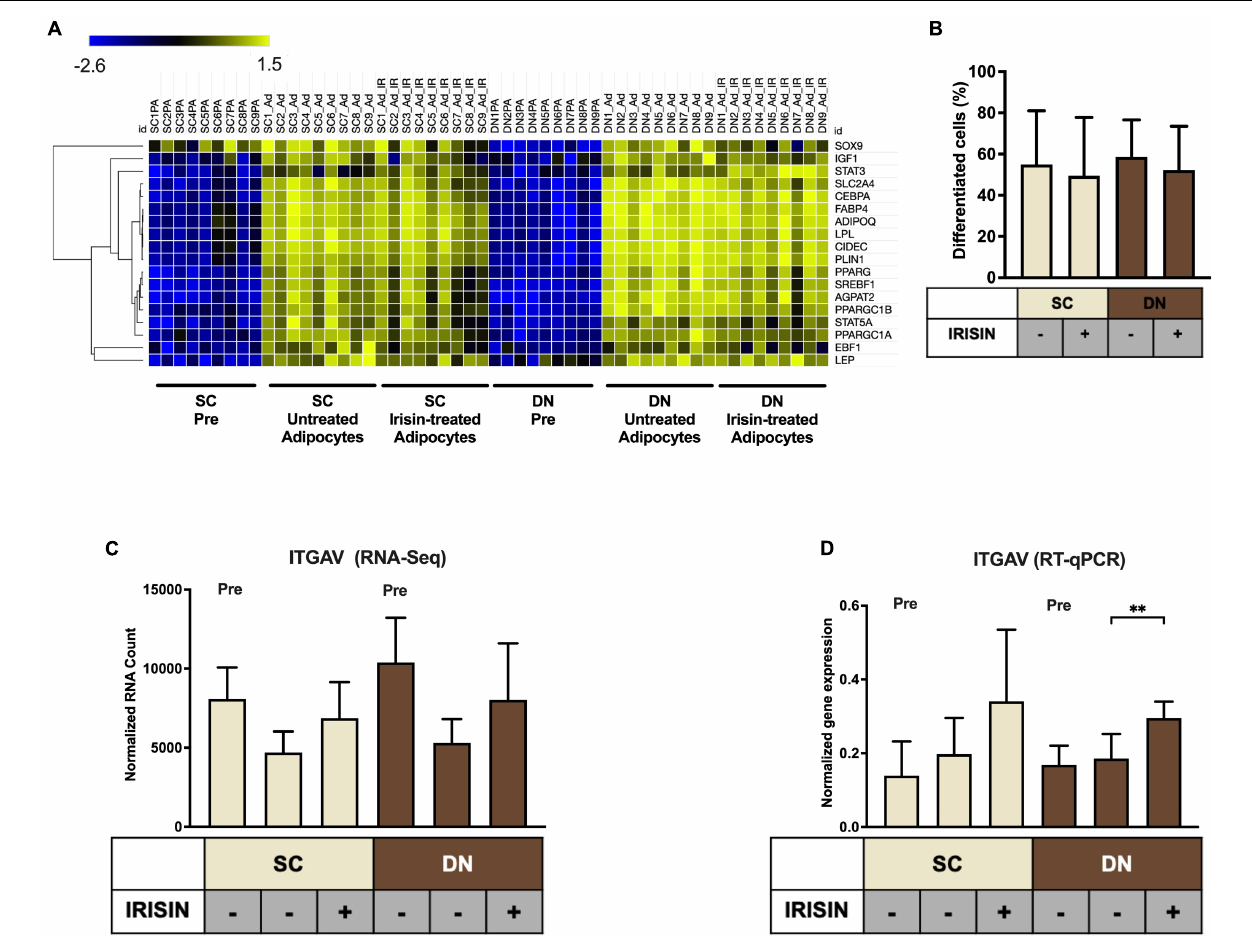
FIGURE 1 | Preadipocytes from subcutaneous (SC) and deep-neck (DN) depots of human neck differentiated at a similar extent irrespective of the presence of irisin. SC and DN preadipocytes (Pre) were differentiated for 2 weeks to white adipocytes. Where indicated, 250 ng/ml irisin was administered during the whole differentiation process. (A) Heatmap illustrating the expression of general adipogenic differentiation markers in samples used for Global RNA Sequencing ( n = 9), (B) Quantification of differentiation rate by laser-scanning cytometry ( n = 9), (C) Quantification of ITGAV gene expression determined by RNA Sequencing ( n = 9), and (D) RT-qPCR, normalized to GAPDH ( n = 5). Data presented as Mean ± SD. ∗∗ p < 0.01. Statistics: Welch’s t -test (D)